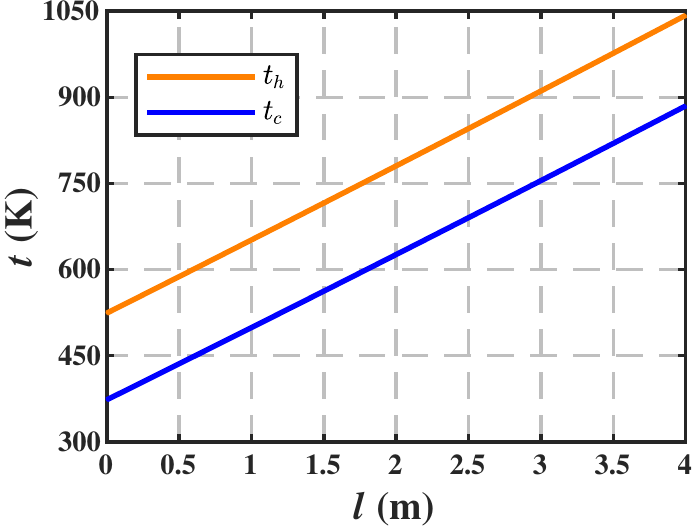
Figure 17. The temperature profiles of the case with the minimum total entropy